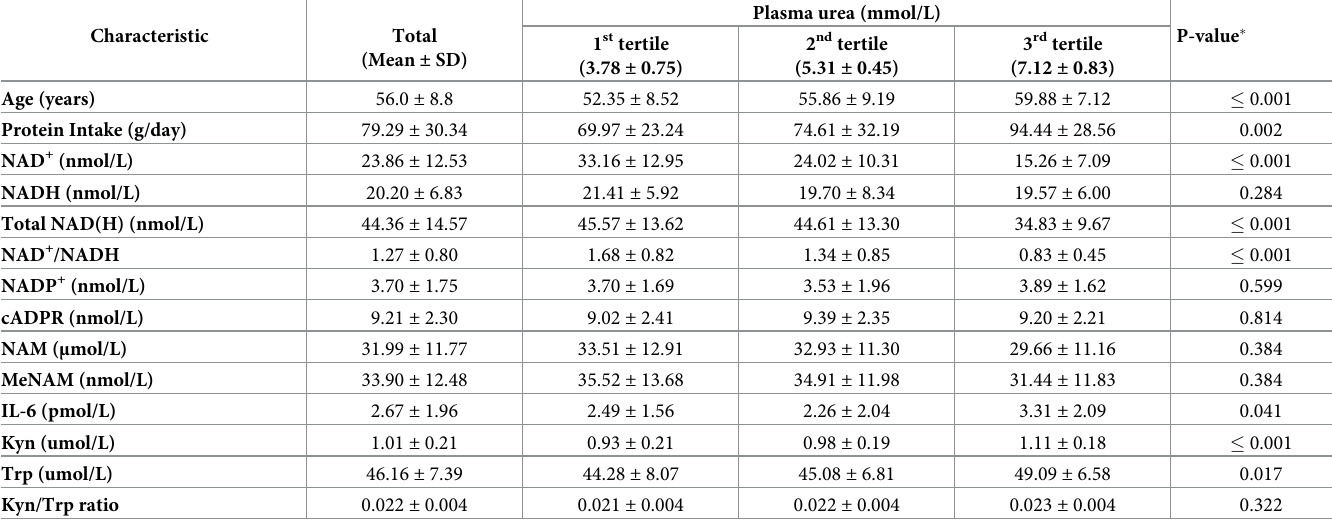
Table 1. Characteristics of the study participants according to plasma urea tertiles.